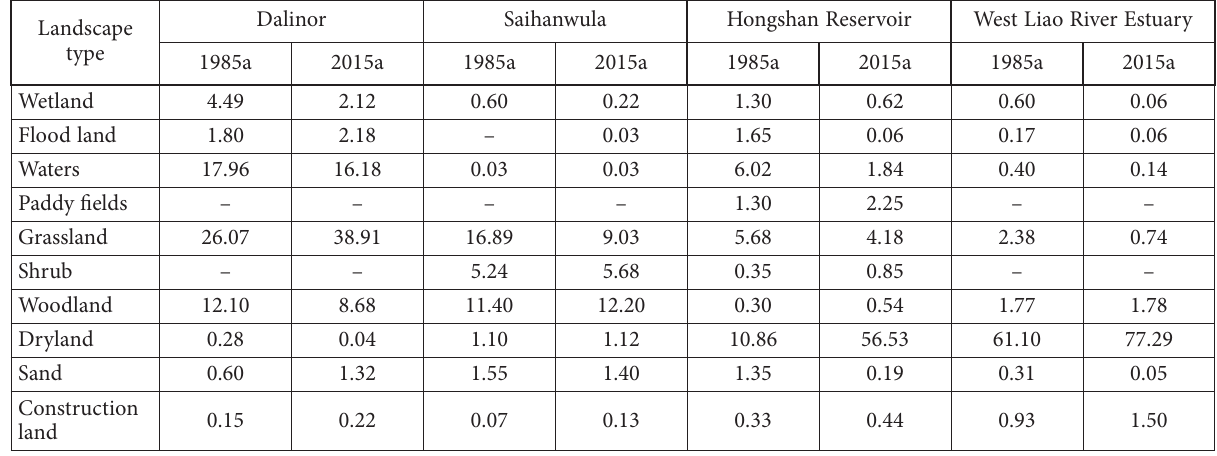
Table 7. Changes in landscape largest patch index in each study area